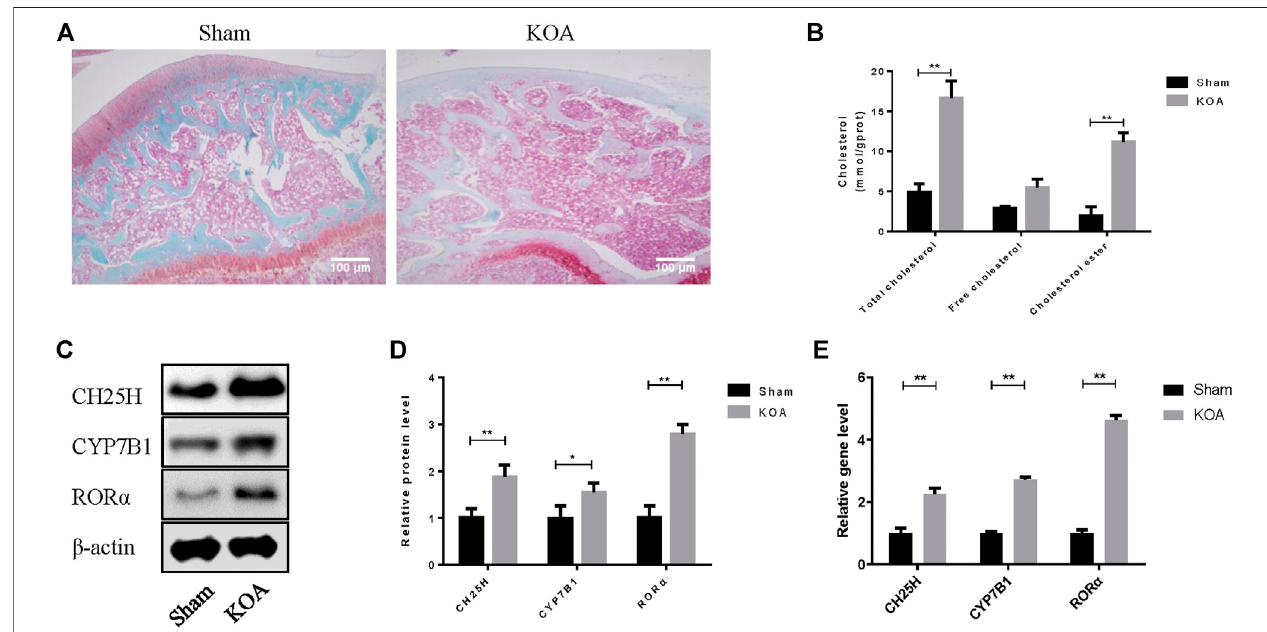
FIGURE1| CH25H isinvolvedincholesterolmetabolismdisordersinKOA. (A) SaffronRed&Fastgreenstainingofcartilagetissue,100 × ,Scalebar (cid:1) 100 μ m. (B) Total cholesterol, free cholesterol and cholesterol ester were detected in cartilage. (C , D) CH25H, CYP7B1, and ROR α expression in catilage were analyzed via western blotting. The band intensity was quanti fi ed by normalizing to β -actin ( n (cid:1) 3). (E) CH25H and CYP7B1 expression in cartilage were analyzed via qRT-PCR. Quantitative data were presented as mean ± SD. * p < 0.05, ** p < 0.01.